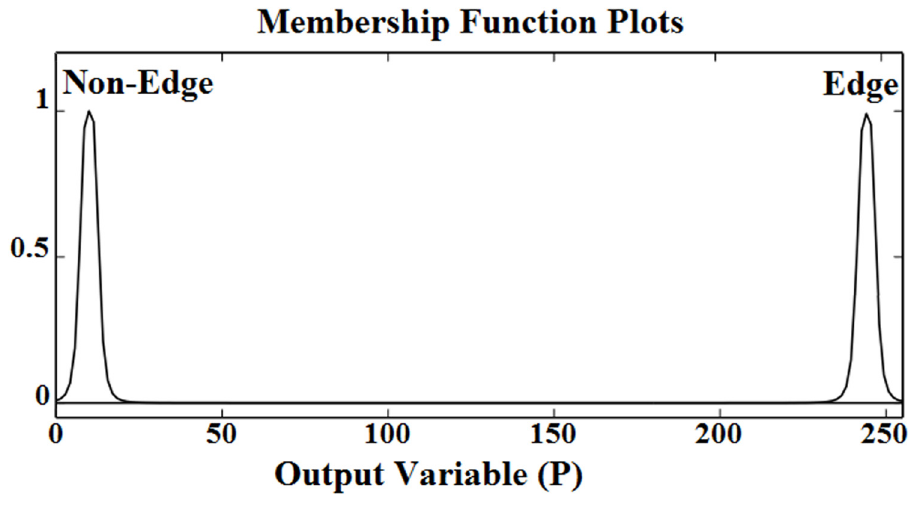
Fig 6. MFs of the output pixel P